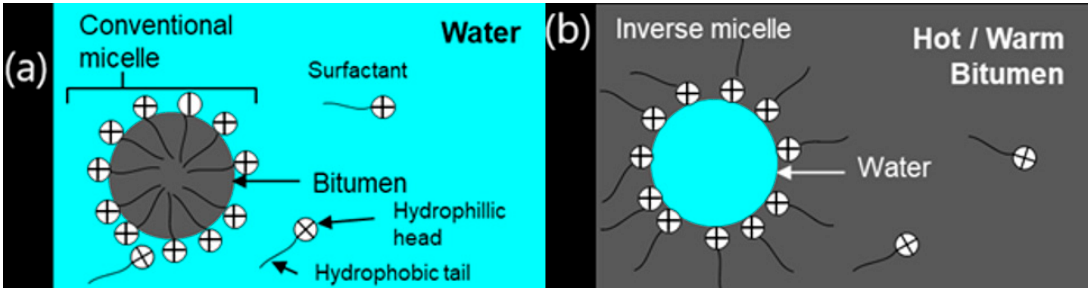
Figure 3. (a) Traditional bitumen emulsion. (b) Stabilized bitumen emulsion. Reprinted